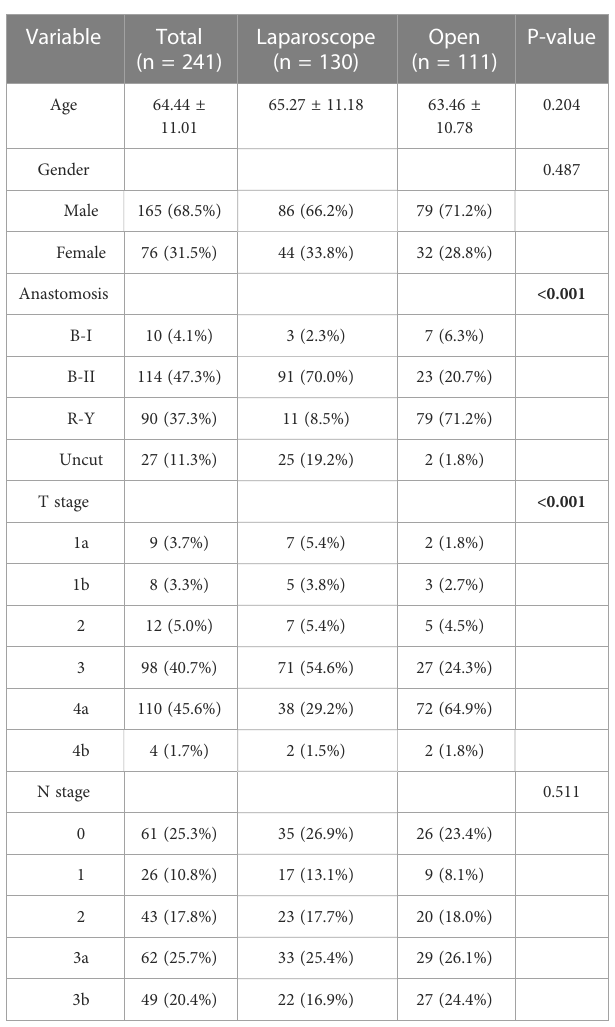
Bold values indicate that the data is statistically signi fi